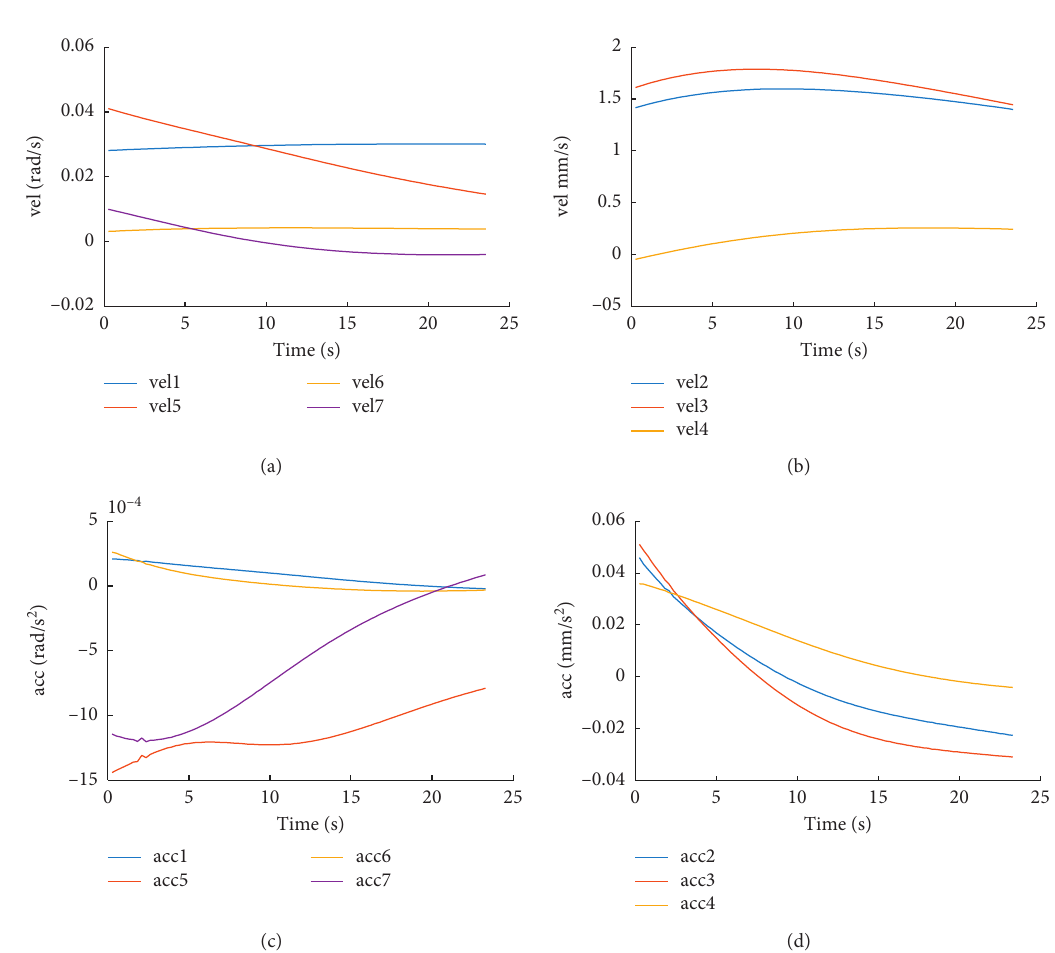
Figure 6: The angular velocity and angular acceleration curves of the first manipulator when Z � 0. vel1–vel7 represent the velocity of joints 1–7, respectively. acc1–acc7 represent the acceleration of joints 1–7,